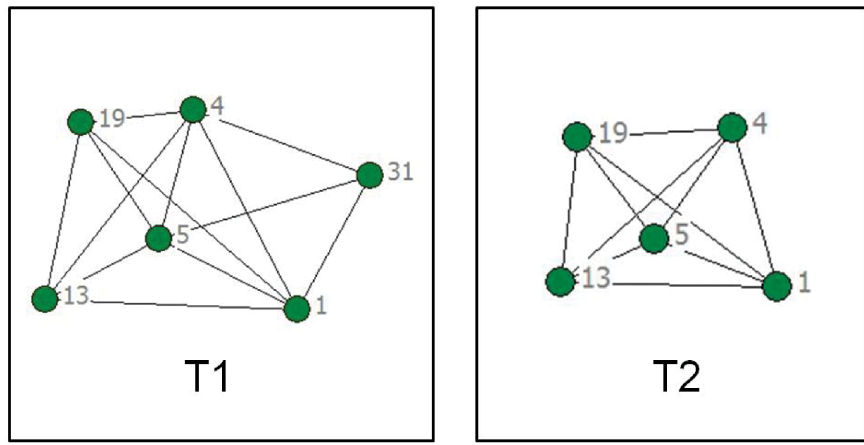
Figure 1. A group with stability index .833.